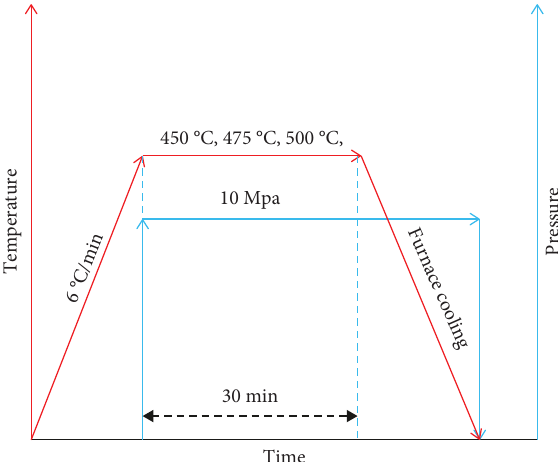
Figure 2: Schematic diagram of the difusion bonding parameters.